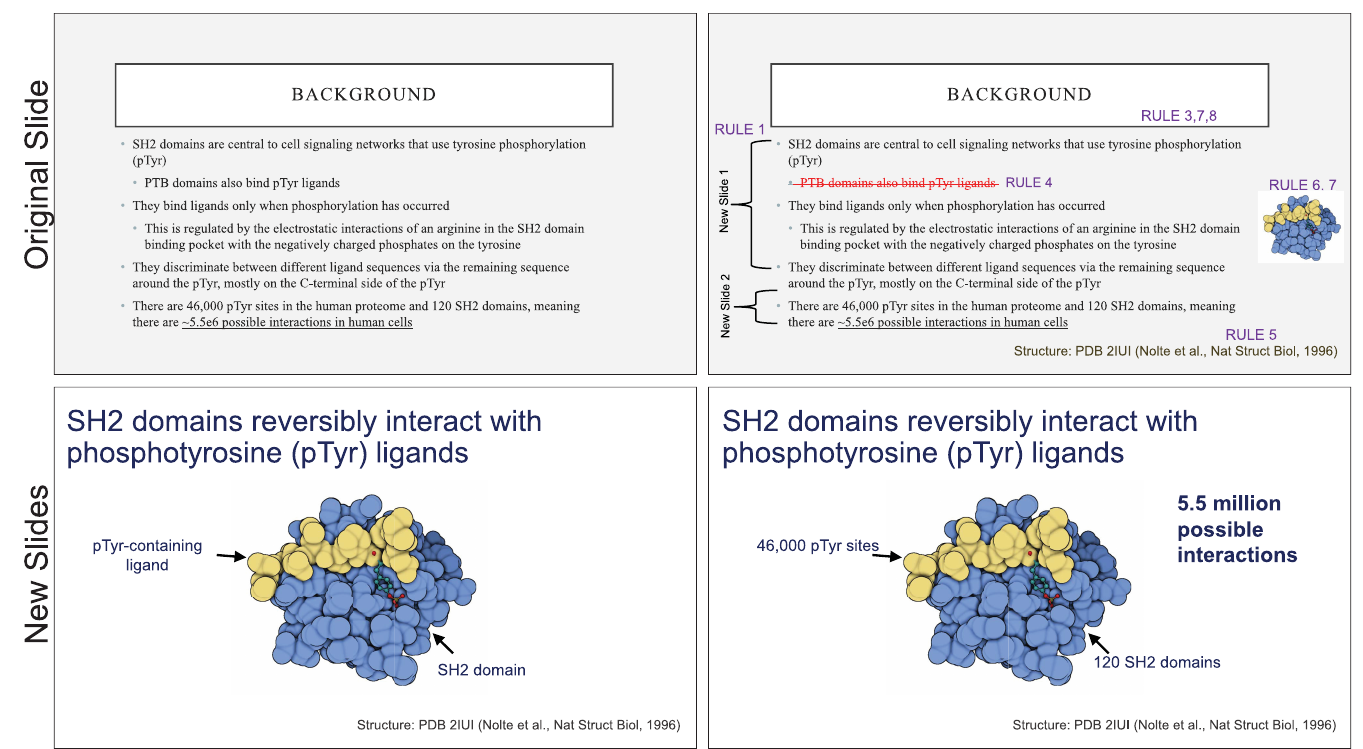
Fig 1. Example of implementing Rules 1–8 to improve a traditional, text-heavy slide. Top left: A background slide that describes the background material on a project from my lab. The slide was created using a PowerPoint Design Template, which had to be modified to increase default text sizes for this figure (i.e., the default text sizes are even worse than shown here). Bottom row: The 2 new slides that break up the content into 2 explicit ideas about the background, using a central graphic. In the first slide, the graphic is an explicit example of the SH2 domain of PI3-kinase interacting with a phosphorylation site (Y754) on the PDGFR to describe the important details of what an SH2 domain and phosphotyrosine ligand are and how they interact. I use that same graphic in the second slide to generalize all binding events and include redundant text to drive home the central message (a lot of possible interactions might occur in the human proteome, more than we can currently measure). Top right highlights which rules were used to move from the original slide to the new slide. Specific changes as highlighted by Rule 7 include increasing contrast by changing the background color, increasing font size, changing to sans serif fonts, and removing all capital text and underlining (using bold to draw attention). P AU : AnabbreviationlisthasbeencompiledforthoseusedthroughoutFig 1 : Pleaseverifythattheentryiscorrect : DGFR, platelet- derived growth factor